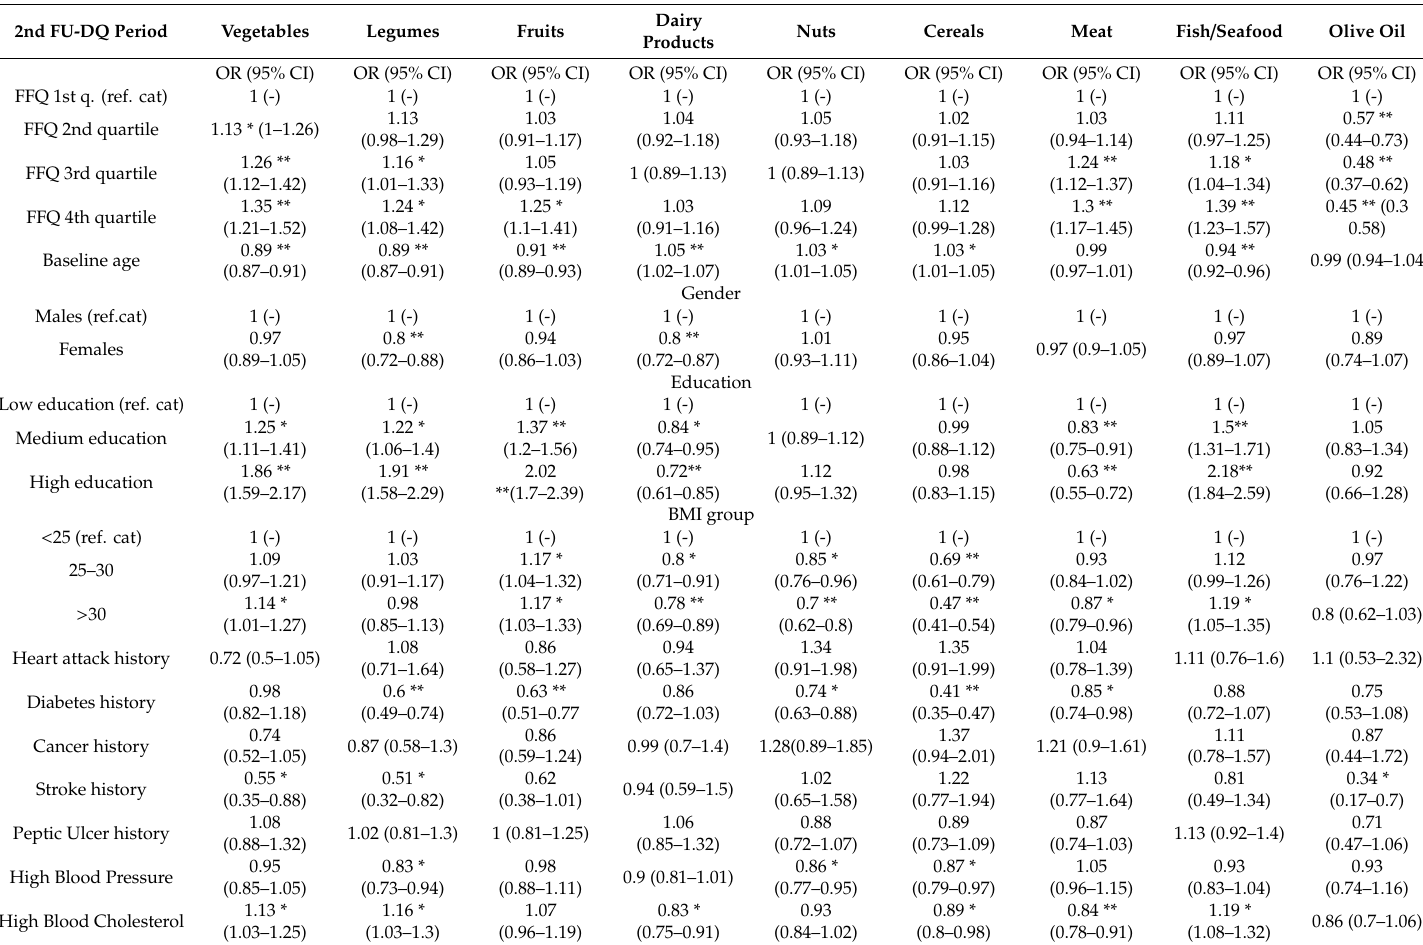
Table 5. Ordinal logistic regression performed on the food items / groups of interest for the 2 nd FU-DQ. The ordinal response variable has three categories (“Much More / More”, “Same”, or “Less / Much Less”). The estimated measure is the Odds Ratio (OR). Confidence intervals of the estimations are also given